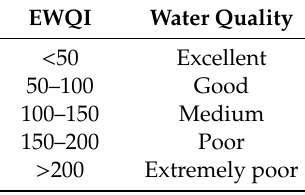
Table 1. Classification criteria of water quality base on the EWQI. Rank EWQI Water Quality